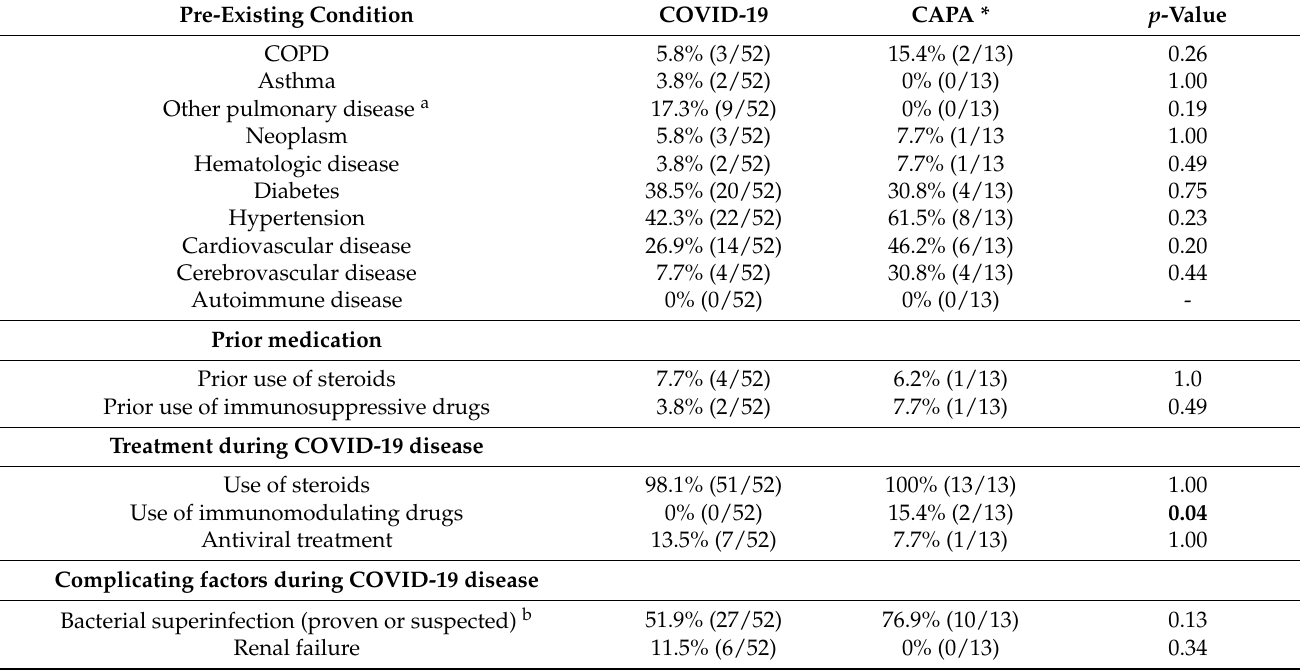
Table 3. Comparison of pre-existing conditions, treatment during COVID-19 disease, prior medication and complication factors during COVID-19